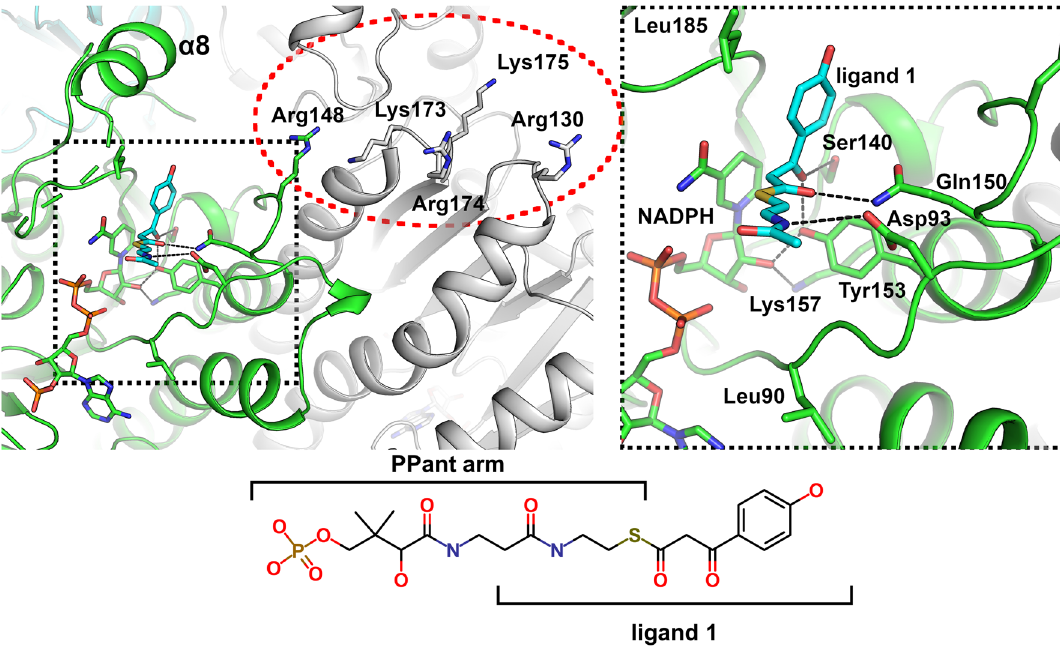
Figure 7. Structural model of AbApeQ–substrate interactions. Substrate-binding sites for 4-hydroxybenzoyl- holo-ACP1. Charged surface residues are marked by a red dotted oval and rendered in stick models and labeled. A tetrameric partner of AbApeQ protomer is rendered in gray. The model of the 4-hydroxybenzoyl-β-ketoacyl group (ligand 1) bound to the active site is shown as a cyan stick model. The structure of the PPant arm with the 3-(4-hydroxyphenyl)-1,3-dioxopropane moiety is depicted. The docked model dubbed ligand 1 is specified. The substrate-binding pocket is in a dashed box and the detailed interaction with the active-site residues is rendered in the right